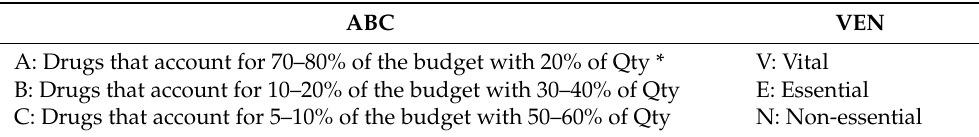
Table 2. ABC/VEN criteria for formulary management in